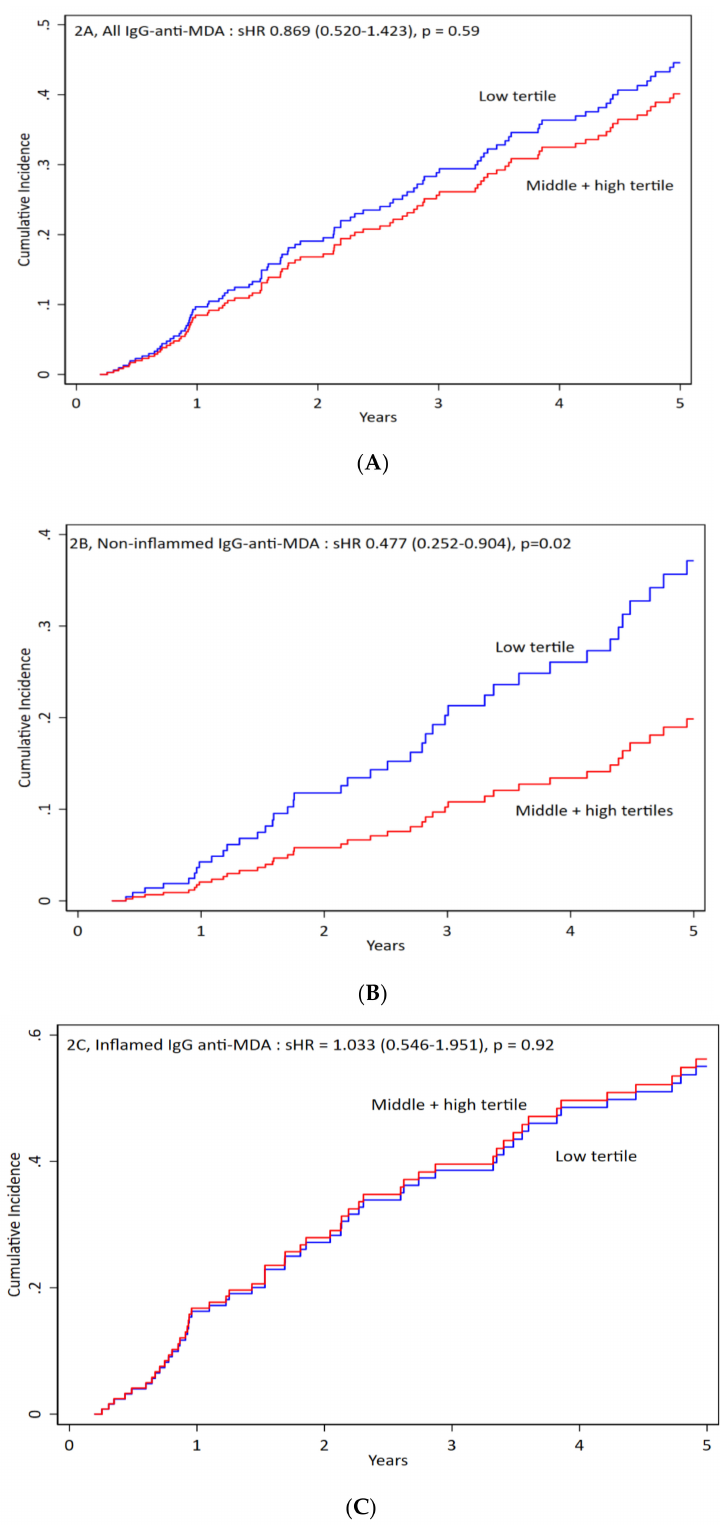
Figure 2. IgG anti-MDA impact on the mortality of all patients and inflamed versus non-inflamed. Patients were divided into three groups: ( A ) for all patients, ( B ) for non-inflamed patients, and ( C ) for inflamed patients. Antibody levels were divided into low vs. middle + high levels of IgG antibodies against malondialdehyde (anti-MDA) for cumulative incidence vs. time. For all patients the sHR is 0.869 (0.520–1.423), p = 0.59. For non-inflamed patients the sHR is 0.477 (0.252–0.904), p = 0.02. For inflamed patients the sHR is 1.033 (0.546–1.951), p =